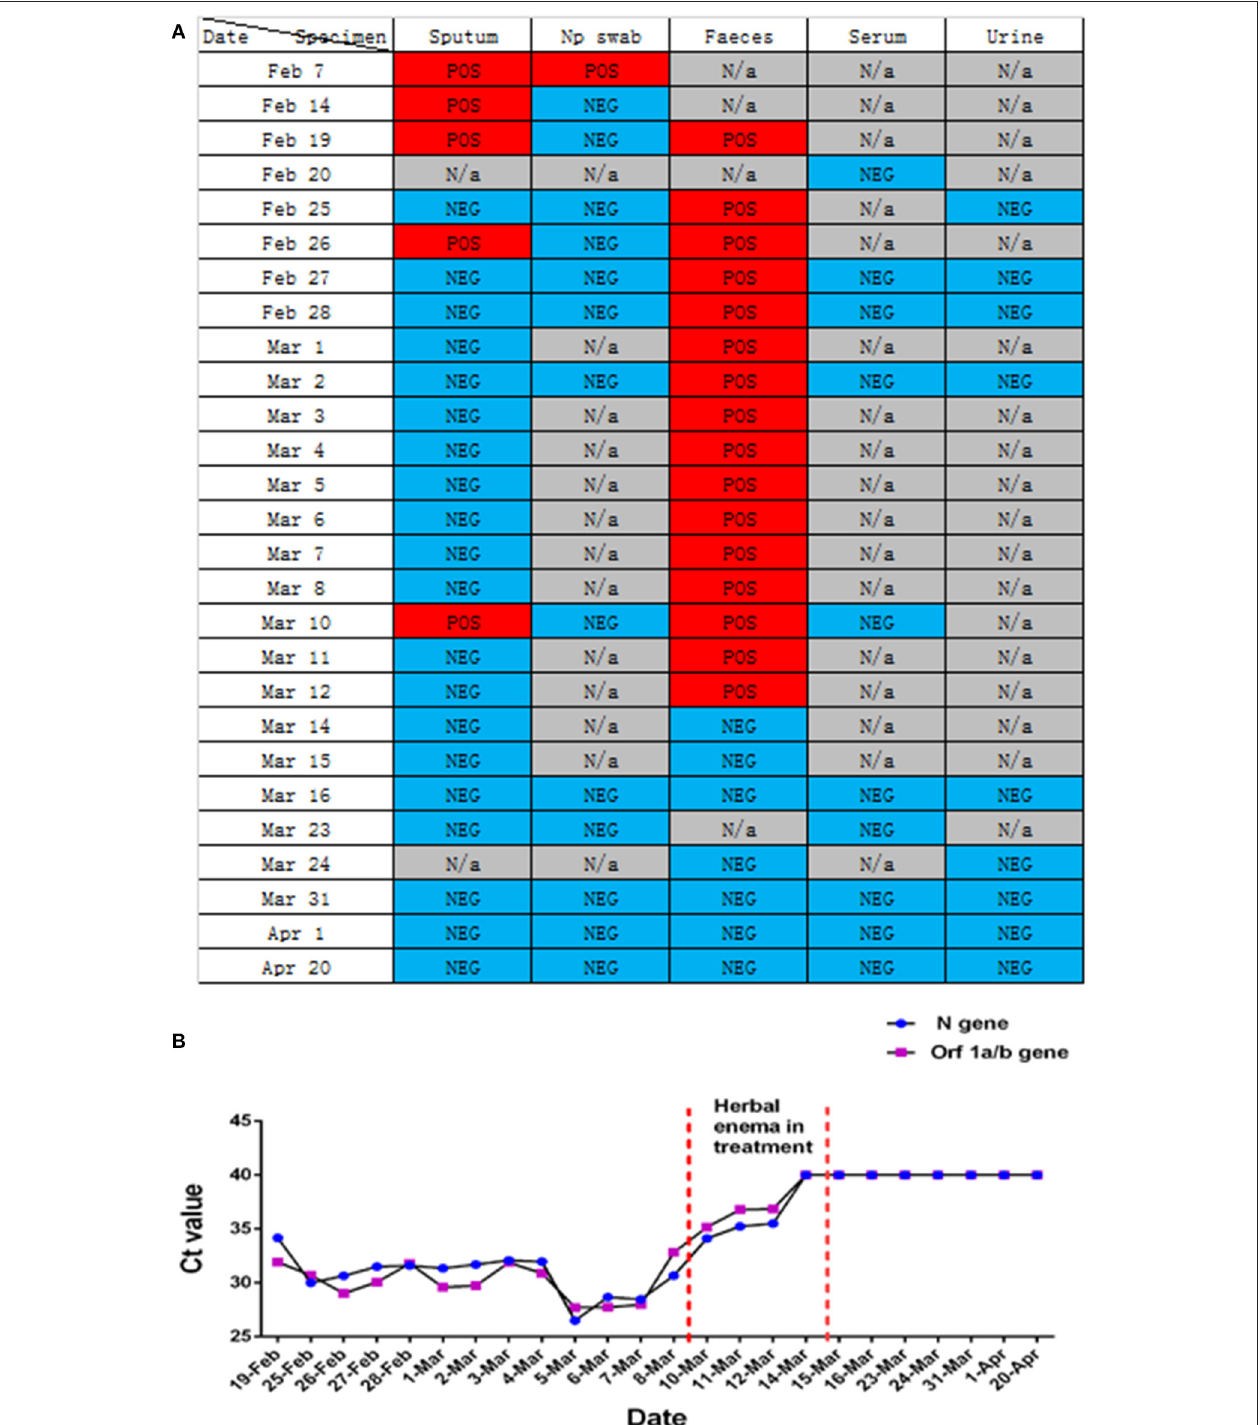
Frontiers in Public Health |